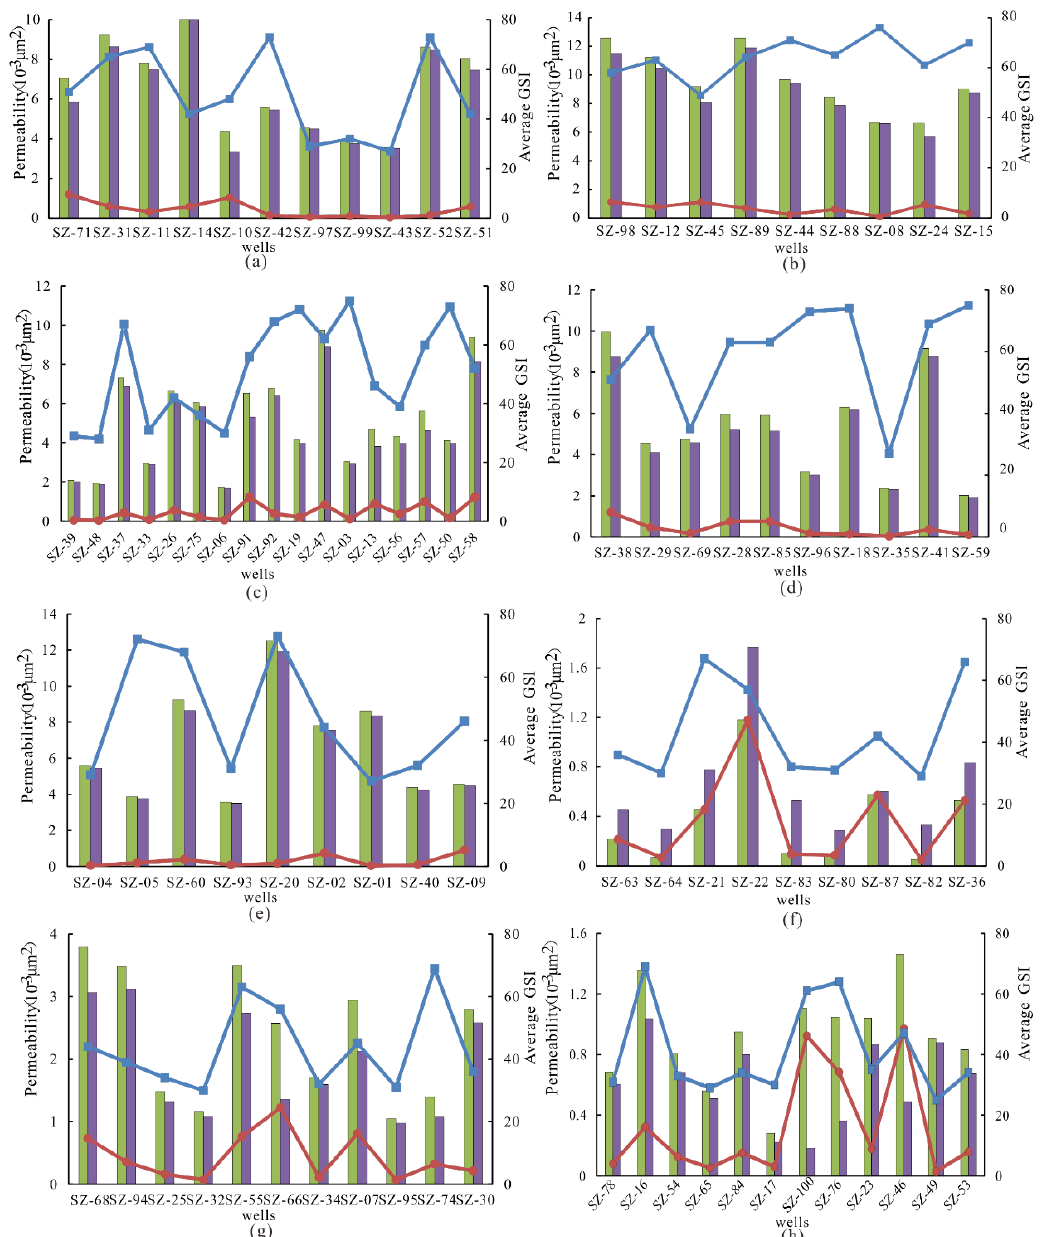
Figure 9. Original permeability and post-fracturing permeability and their difference with fracturing curves of different types. ( a ) Stable type I. ( b ) Stable type II. ( c )Descending type I. ( d ) Descending type II. ( e ) Rising type I. ( f ) Rising type II. ( g ) Fluctuating type I. ( h ) Fluctuating type II.